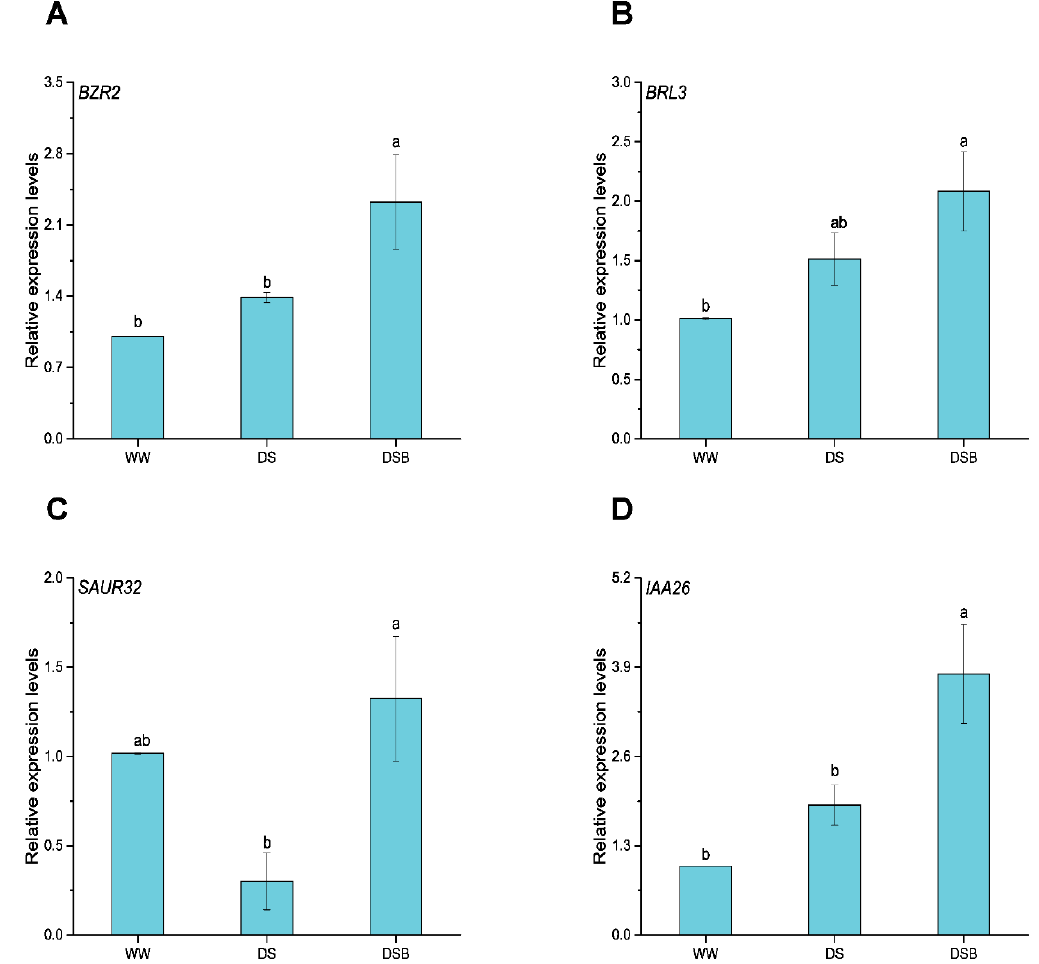
Figure 8. Drought tolerance-related gene expression is mediated by the BR and IAA signaling pathways. This figure displays gene expressions such as BZR2 ( A ), BRL3 ( B ), SAUR32 ( C ), and IAA26 ( D ). The data are presented as means ± SE in the three treatments including WW (well-watered), DS (drought stress), and DSB (drought stress + 0.05 mM 2,4-epibrassinolide application). Error bars represent SE of the mean; different letters on bars show significant differences at p < 0.05 using the LSD test.